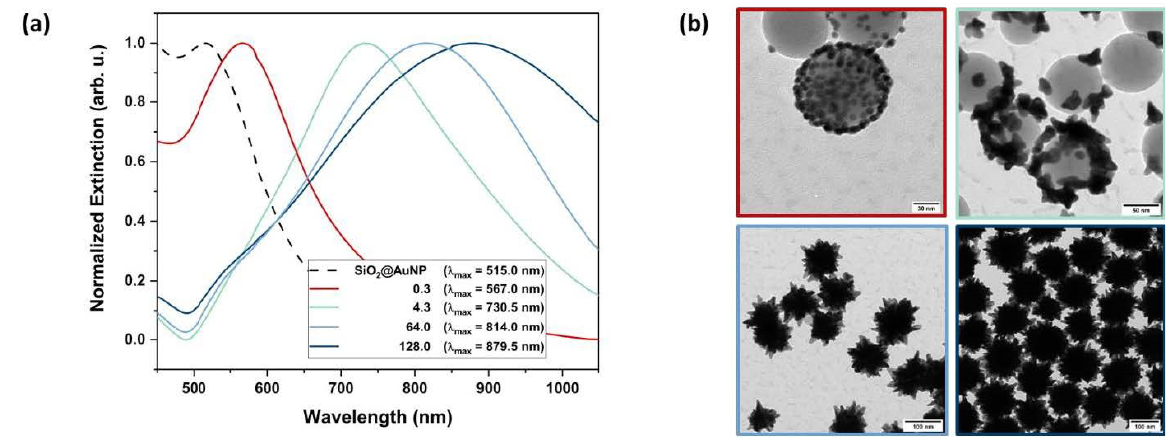
Figure 3. Characteristics of the formed nanostructures via UV-Vis and TEM. Extinction spectra ( a ) of the immobilized AuNP seeds (dashed line) and the resulting SiO 2 @AuNS nanostructures after reaction with different [HAuCl 4 ]/[seed] mass ratios (solid lines). The according TEM images ( b ) show the stepwise growth of the gold nanostructure on the SiO 2 -NP surface and are color-coded with respect to the UV-Vis spectra. The shell formation is observed for R lager than 64.